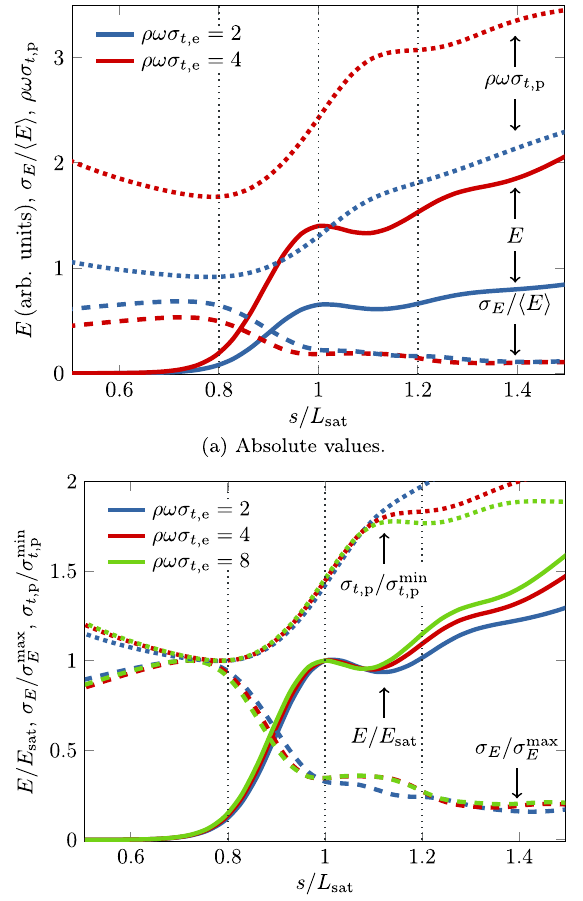
FIG. 3. Simulations on the evolution of FEL related parame- ters versus normalized undulator length s=L sat : (a) Evolution of the energy E in the radiation pulse (solid lines), the fluctuations of the radiation pulse energy (cid:4) E = h E i (dashed lines), and the normalized rms FEL radiation pulse duration (cid:8)!(cid:4) t;p (dotted lines) for normalized rms electron bunch lengths of (cid:8)!(cid:4) t; e ¼ 2 and 4 (blue and red), and (b) the normalized values of E=E sat , =(cid:4) max (cid:4) =(cid:4) min (cid:4) E t;p t;p for the rms electron bunch lengths of E , and (cid:8)!(cid:4) ¼ 2 , 4, and 8 (blue, red, and t; e